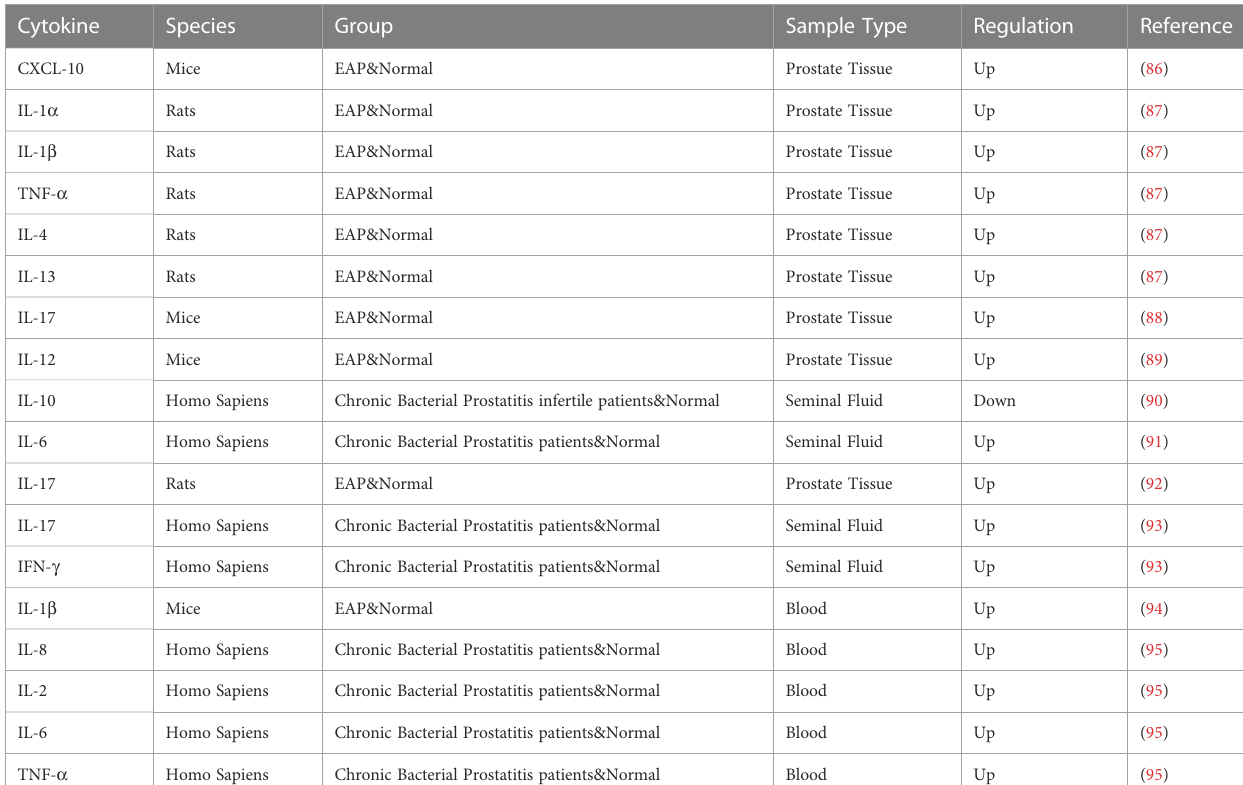
TABLE 3 Cytokines and